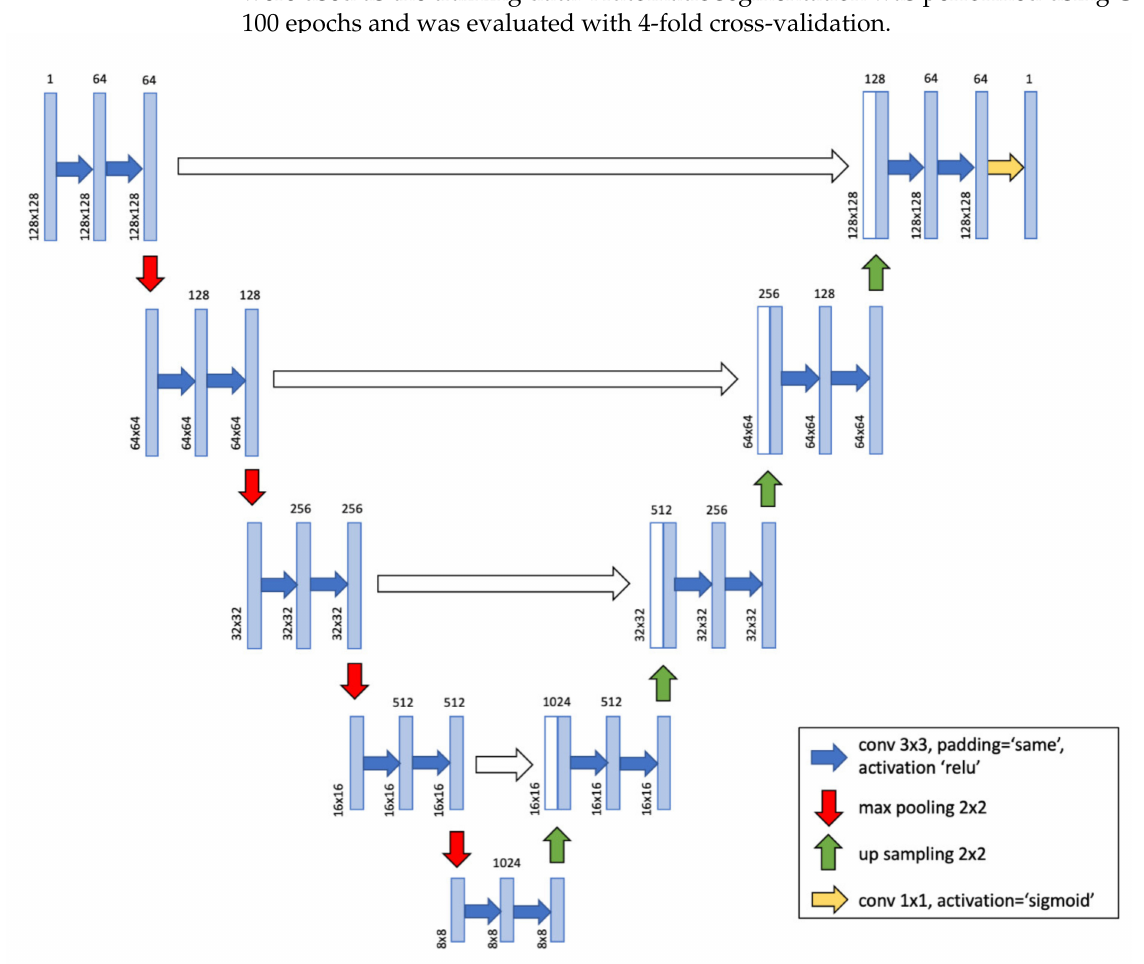
Figure 2. U-Net architecture. A deep learning network with U-net architecture was used for this